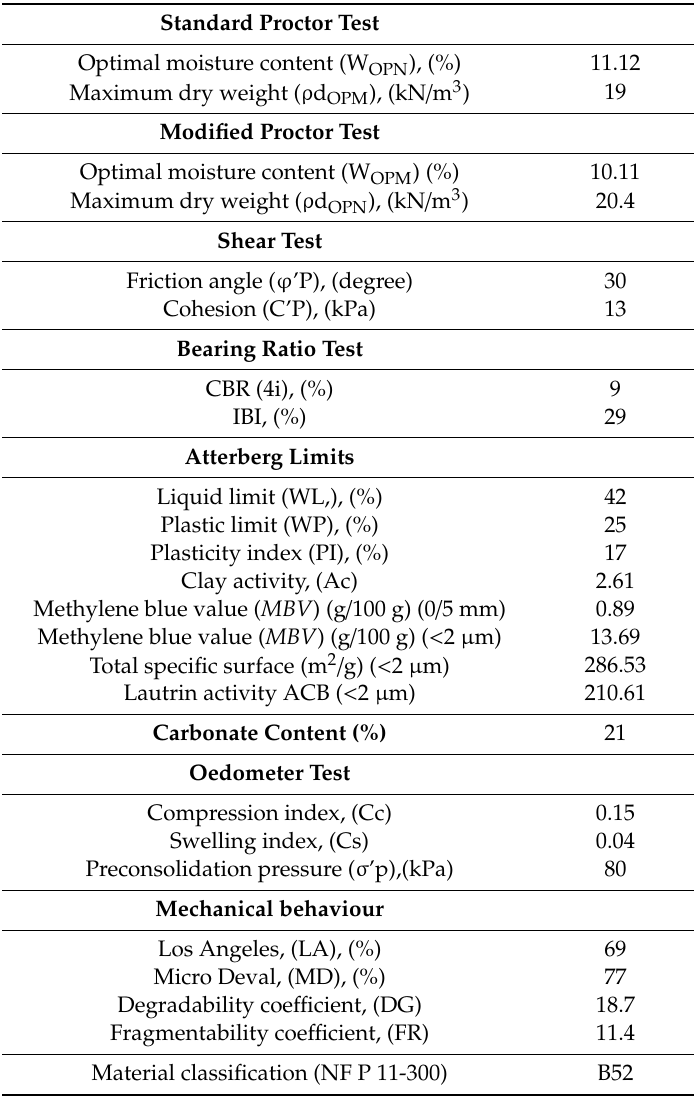
Table 5. Geotechnical properties of